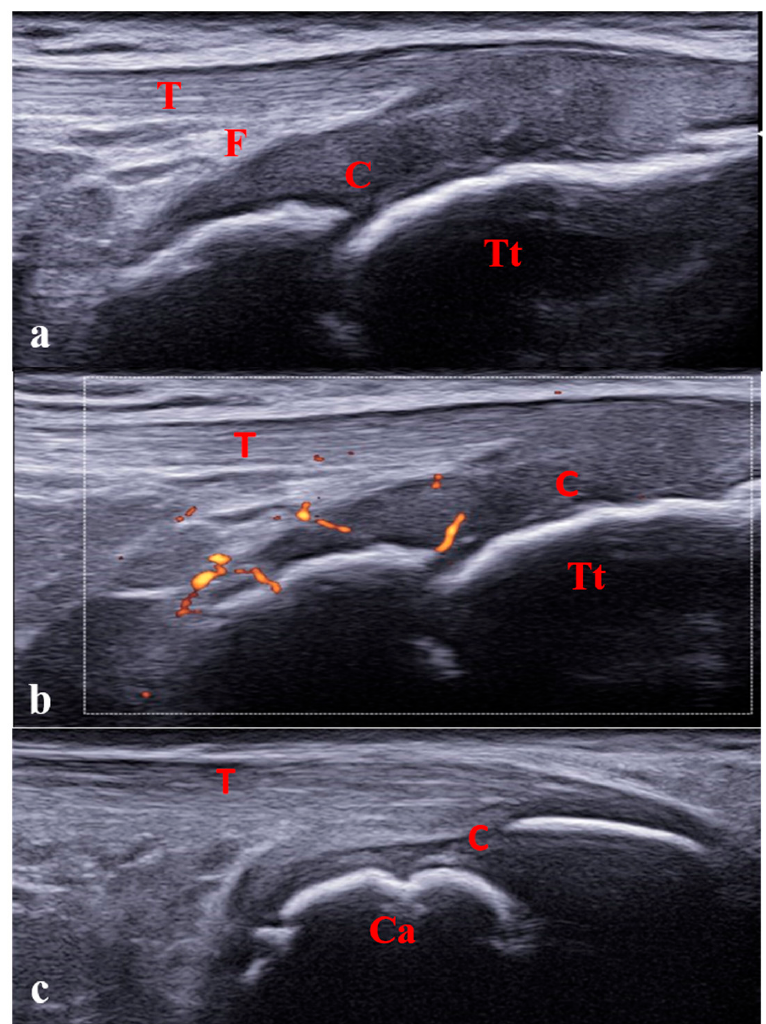
Figure 1. Pediatric ultrasound peculiarities. Increased ratio of cartilage to bone ( a ) and physiological cartilage vascularization ( b ) in a 6-year-old girl. ( c ) Physiological irregularity of calcaneus bone surface owing to the presence of ossification centers in a 10-year-old boy. C: cartilage; Tt: tibial tuberosity; Ca: calcaneus; T: tendon; F: fat.